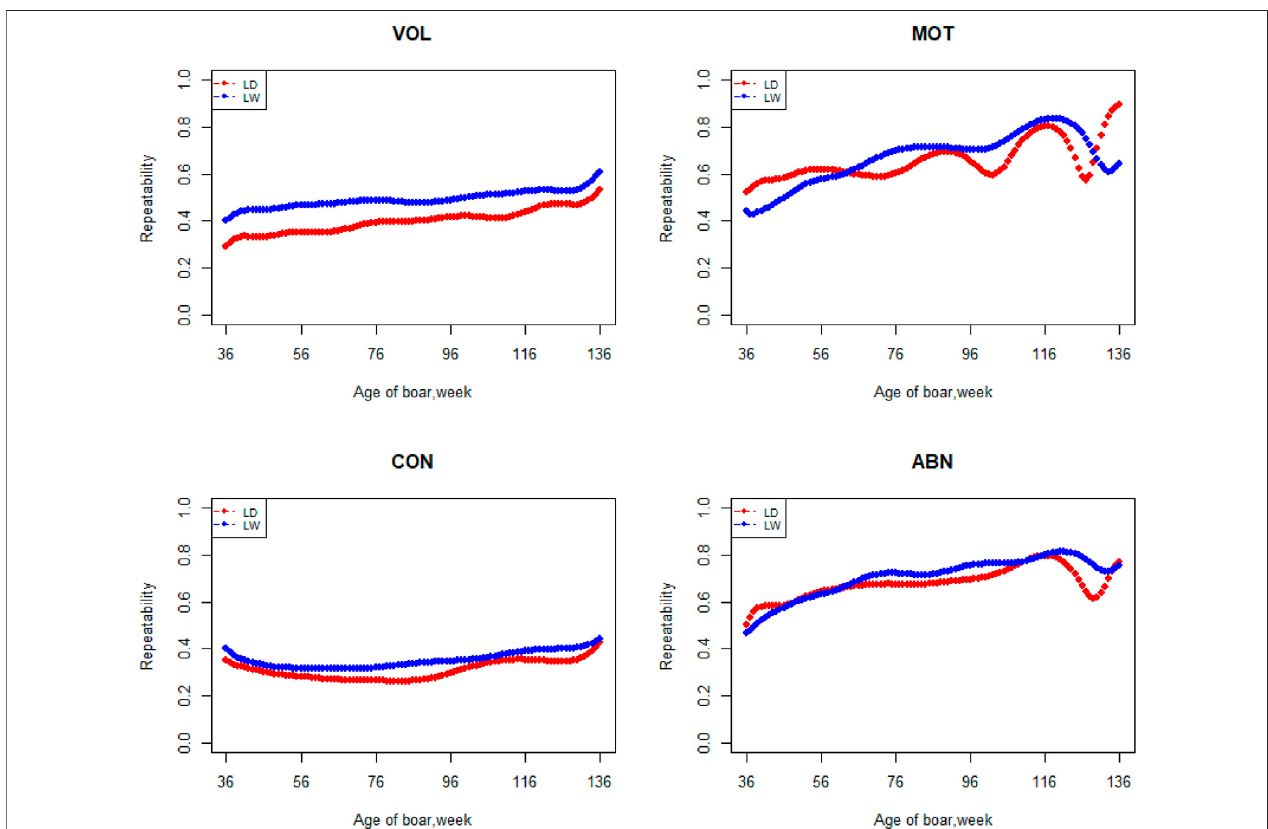
FIGURE 5 | Repeatability from 36 weeks to the age of 136 weeks, estimated with a random regression animal model.